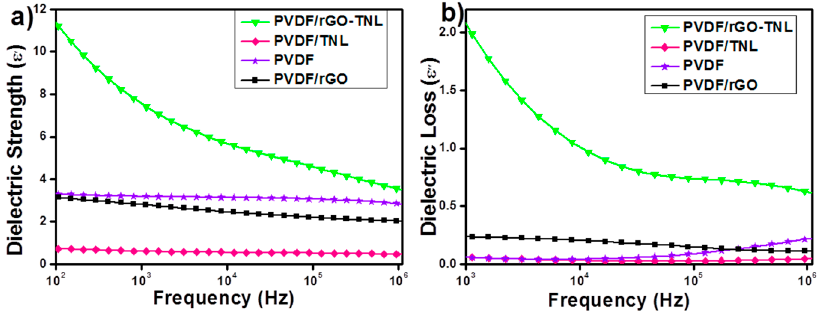
Figure 14. Dielectric permittivity storage ( a ); and loss ( b ) of PVDF control and its composite samples with variable nanoparticle fillers.